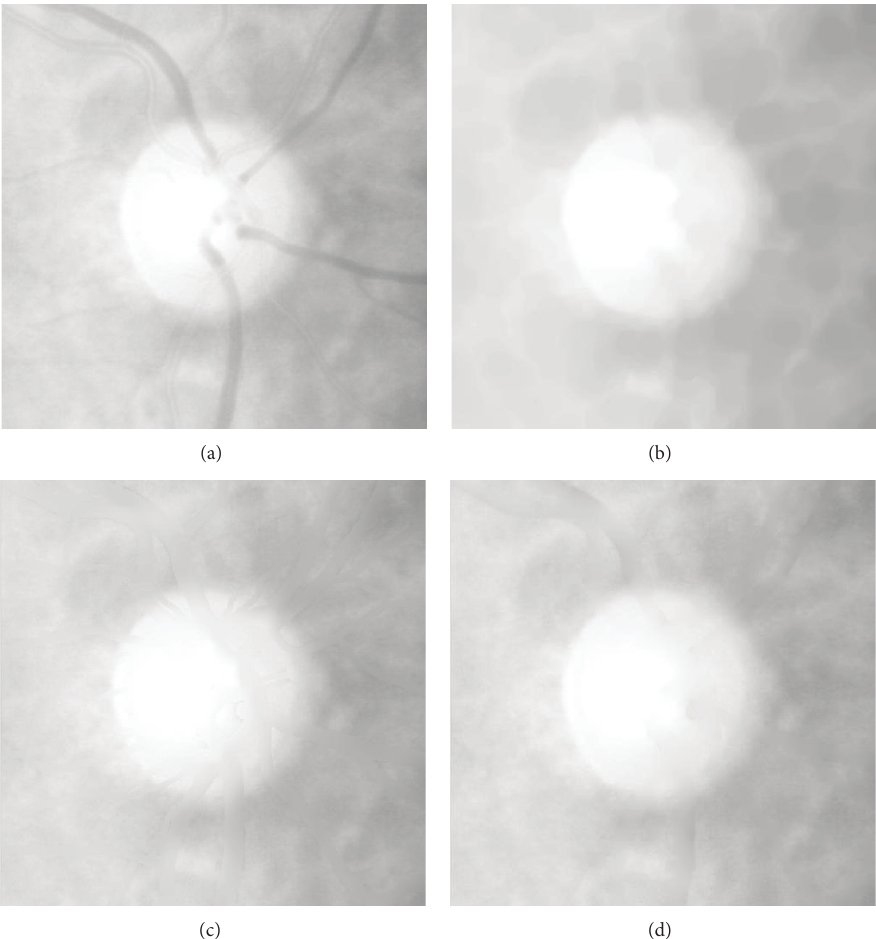
Figure 4: Vessel removal results. (a) Red channel image. (b) Close operation. (c) Mean pixels replacement. (d) PDE